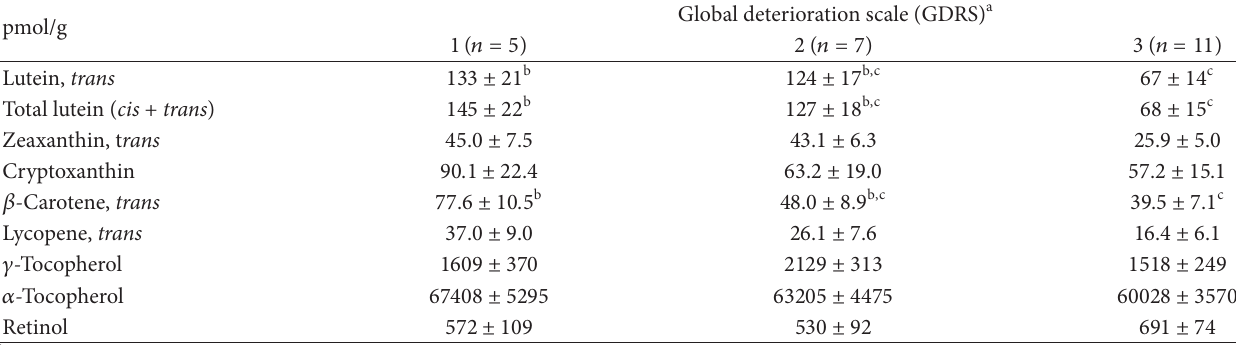
Table 5: Mean ( ± SEM) concentrations of carotenoids, 𝛼 -tocopherol, and retinol in the brain (average of cerebellum, frontal, occipital, and temporal cortices) based on premortem GDRS scores in decedents with normal cognitive function (GDRS = 1), subjective mild memory loss (GDRS = 2), and mild cognitive impairment (GDRS =